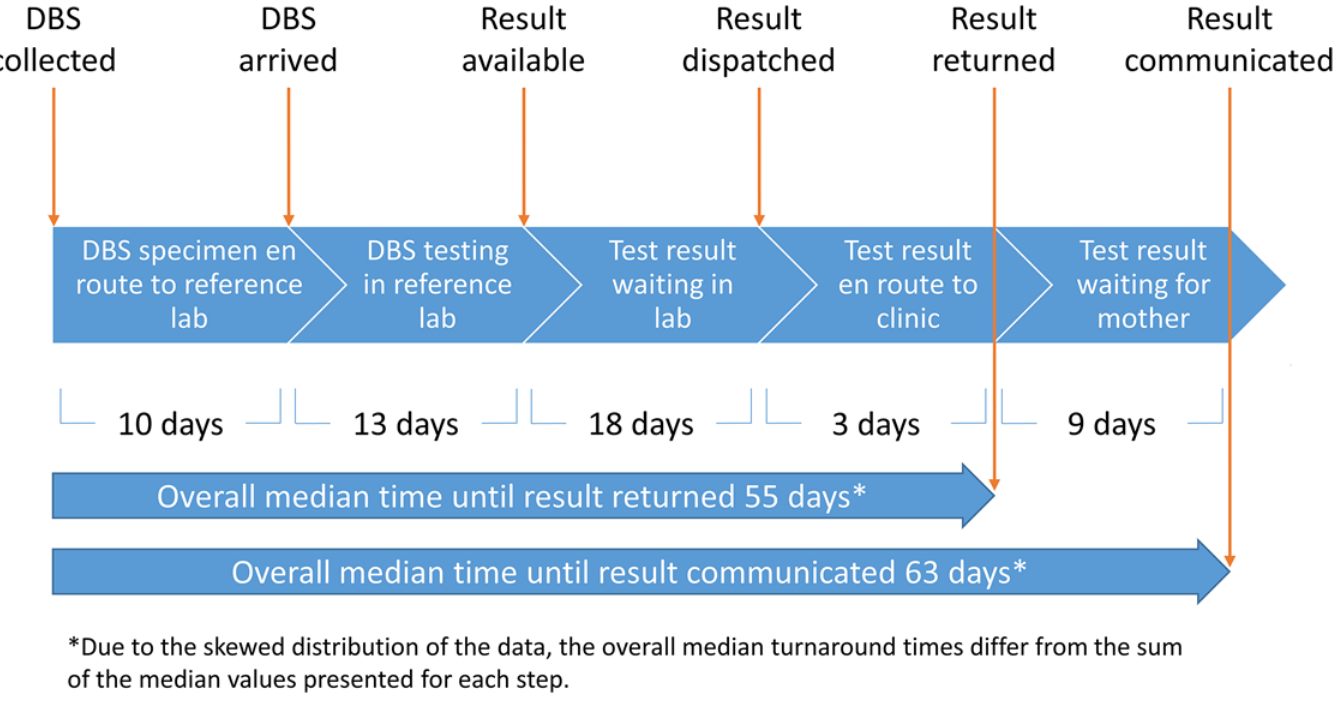
Fig 1. Flow diagram of steps required for rural dried blood spot HIV viral load testing and median times to completion at